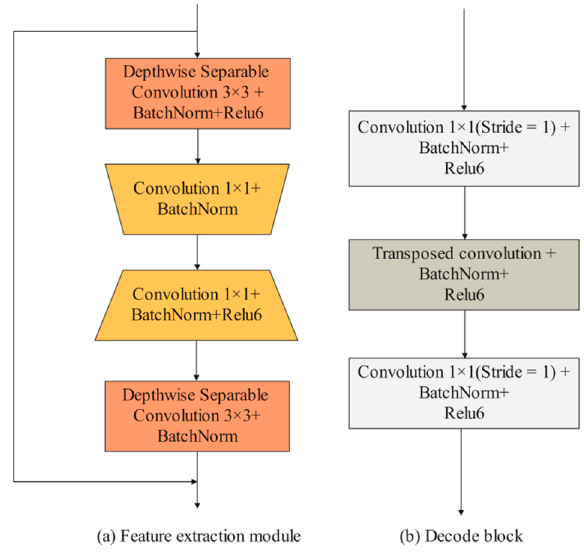
Figure 4. The design of feature extraction module and decode block.